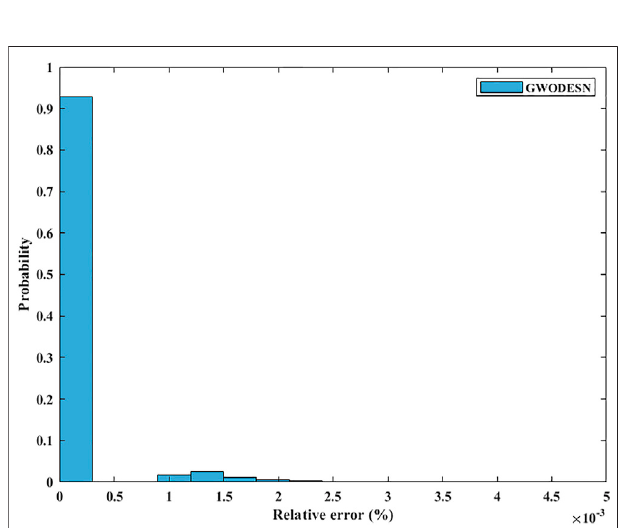
FIGURE 11 | Relative error distribution for